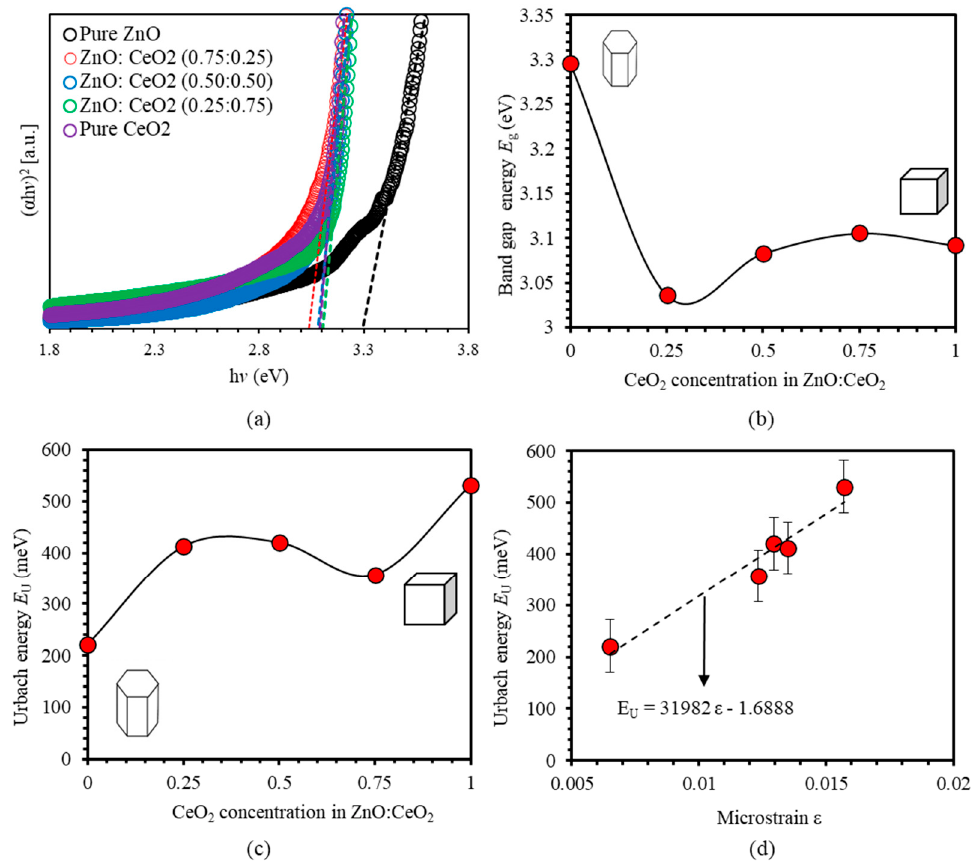
Figure 9. ( a ) Tauc plot of pure ZnO, pure CeO 2 and ZnO:CeO 2 mixed oxides thin films, ( b ) Band gap energies ( E g ) of ZnO:CeO 2 mixed oxides thin films as a function of CeO 2 concentrations, ( c ) Urbach energy ( E U ) of pure ZnO, pure CeO 2 and ZnO:CeO 2 mixed oxides thin films and ( d ) Plot of the relationship between Urbach energy E U and microstrain ε of ZnO:CeO 2 mixed oxides thin